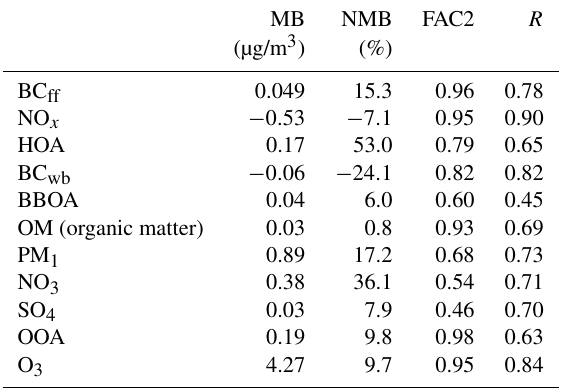
Table 4. Metric values (MB, NMB, FAC2 and r ) for the evaluation of A 3 Q during January–February 2020.